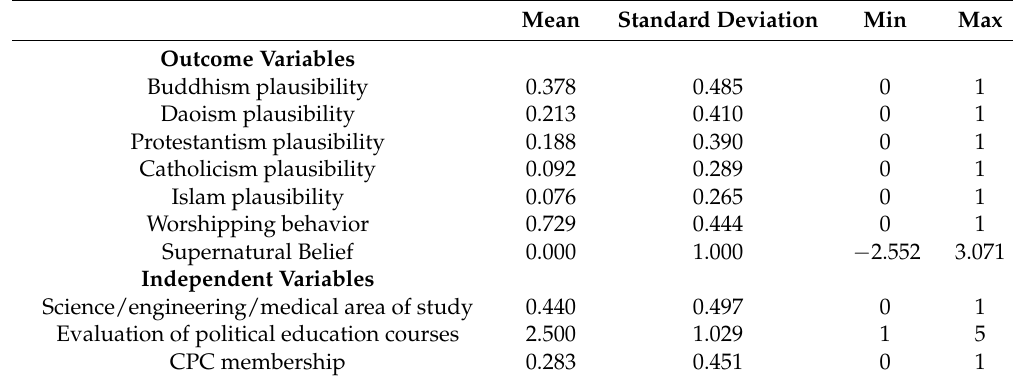
Table 1. Descriptive